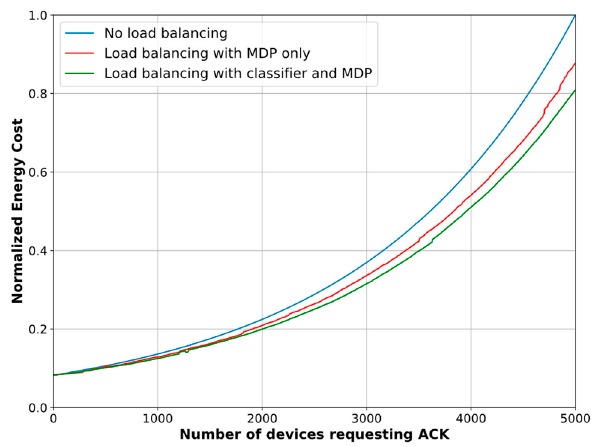
Figure 11. Network EDC reduction based on proposed scheme.